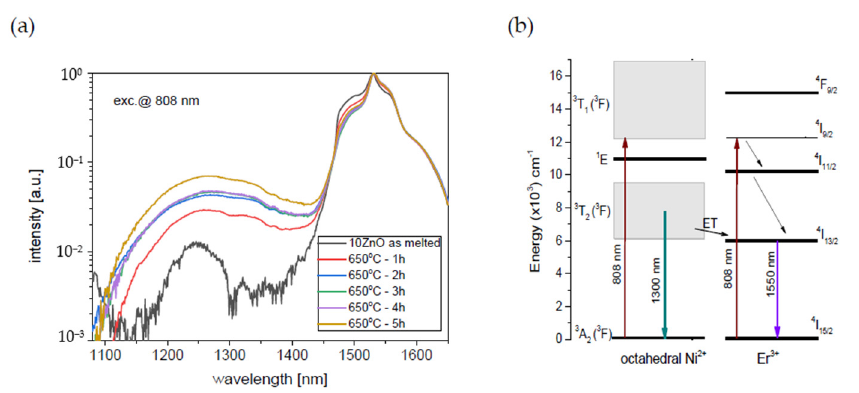
Figure 9. ( a ) Infrared luminescence spectra of 0.1NiO/0.1Er 2 O 3 co-doped GGK glass and transparent glass-ceramics with 10 ZnO (mol.%), (HT@650 ◦ C for 1–5 h), ( b ) simplified energy level diagram of the Ni 2+ and Er 3+ ions in the GGK glass-ceramics host with possible transitions and Ni 2+ to Er 3+ energy transfer, λ exc = 808 nm.